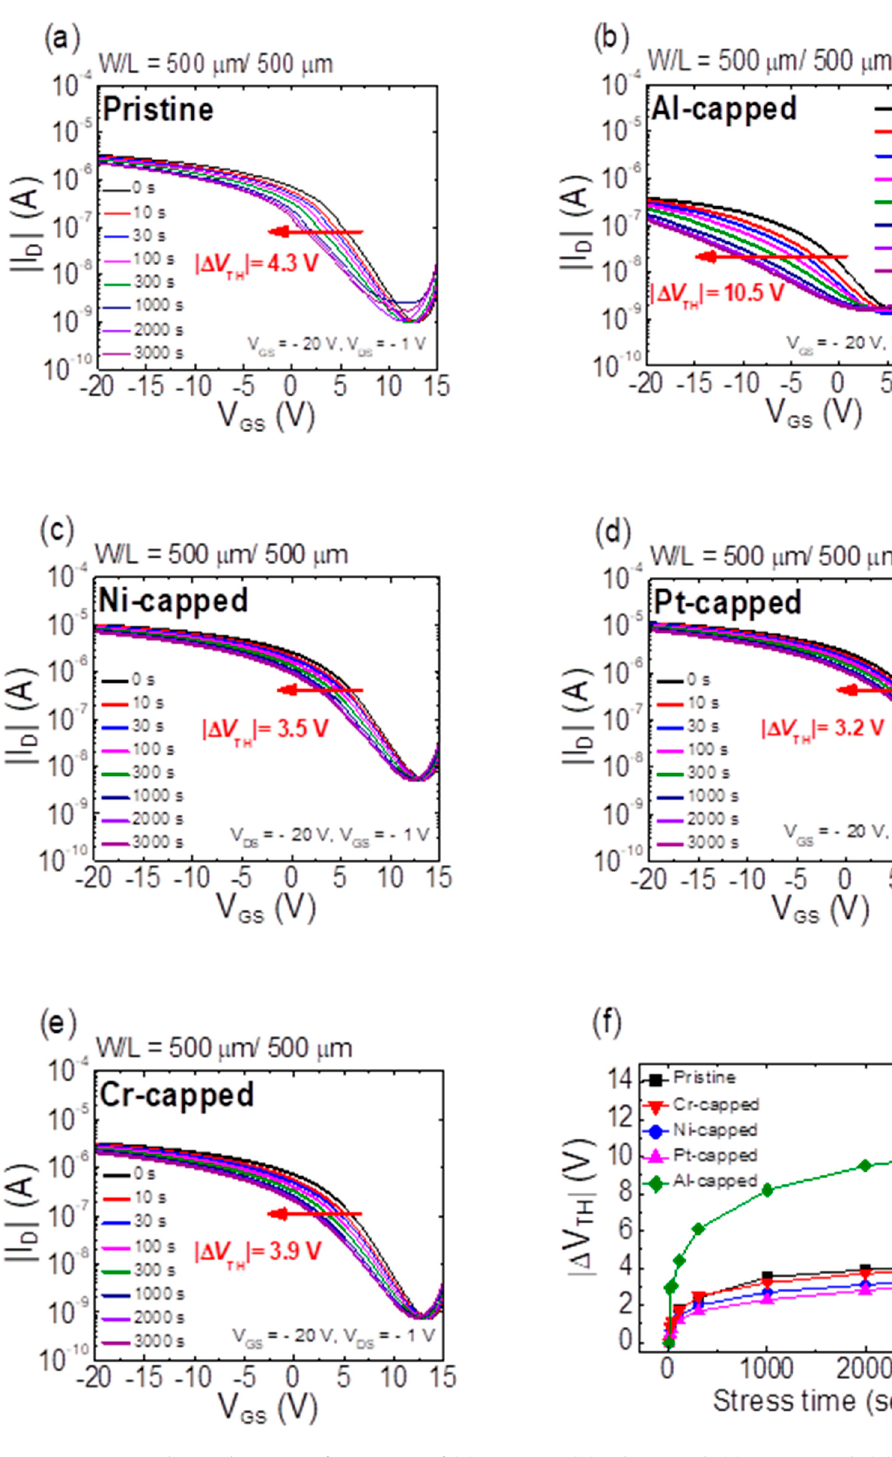
Figure 7. Time-dependent transfer curves of ( a ) pristine, ( b ) Al-capped, ( c ) Ni-capped, ( d ) Pt-capped, and ( e ) Cr-capped SnO TFTs under an application of constant bias stress of V GS = − 20 V and V DS = − 1 V. ( f ) Summary of ∆ V TH after a 3000 s stress in SnO TFTs with every metal capping layer. Figure 8a–e display the output curves measured from the SnO TFTs with different capping metals. Figure 8 indicates that the output curves obtained from the pristine, Ni-capped, and Pt- capped SnO TFTs exhibit an excellent behavior with a clear pinch-off. However, severely distorted output curves were measured from the Al-capped SnO TFT, which can be attributed to the impeded